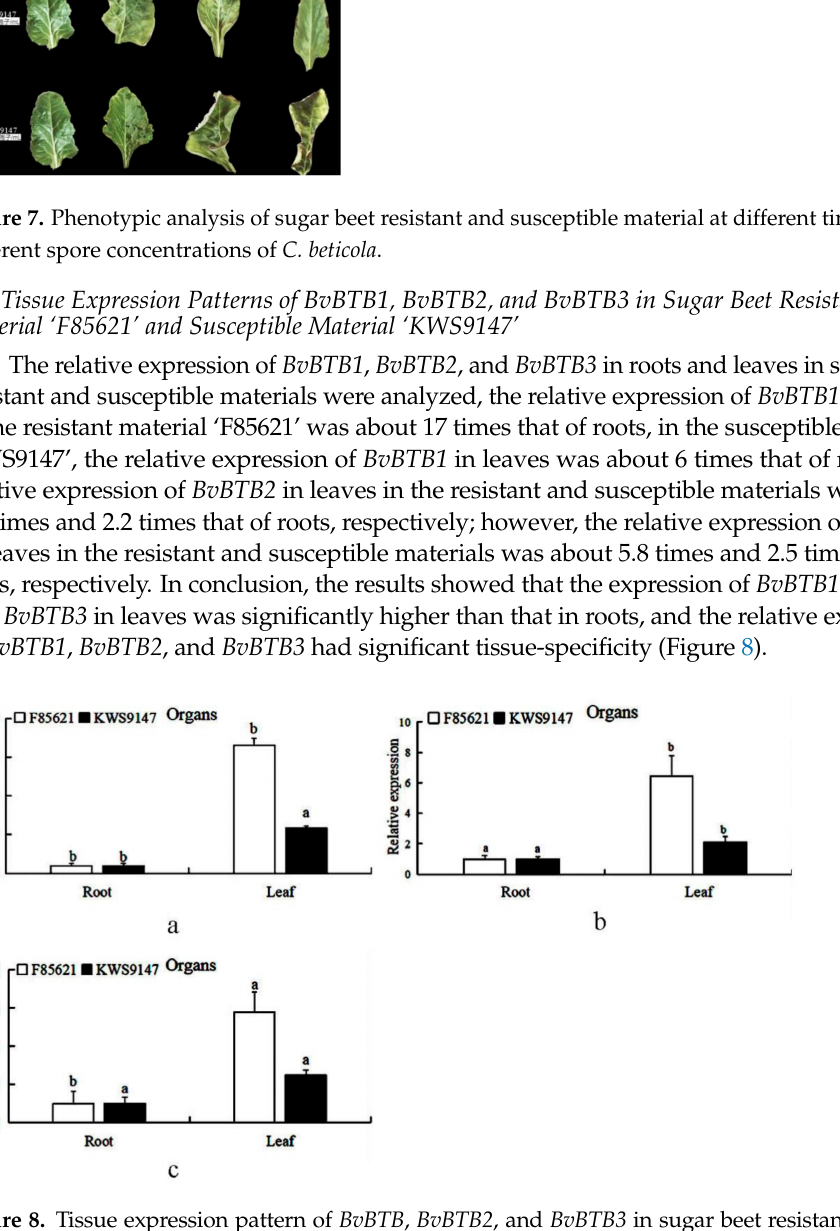
Figure 8. Tissue expression pattern of BvBTB , BvBTB2 , and BvBTB3 in sugar beet resistant